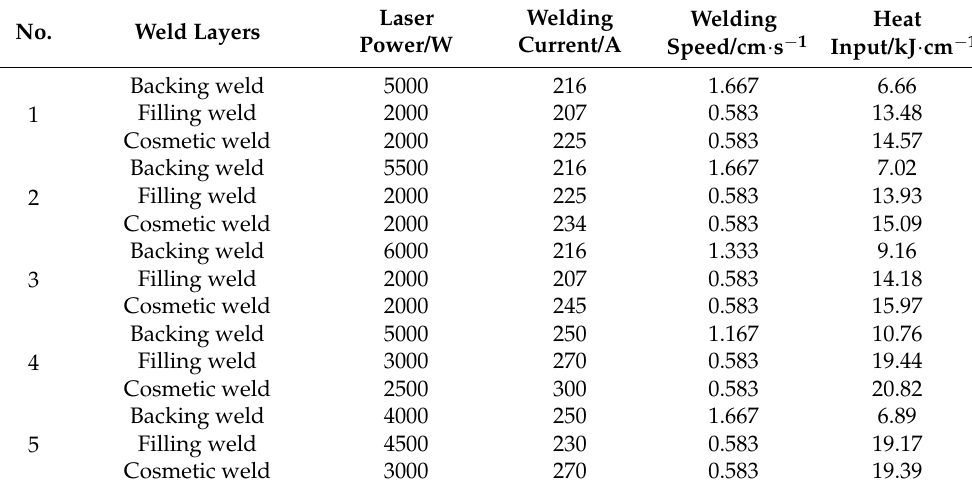
Table 3. Detailed parameters for each